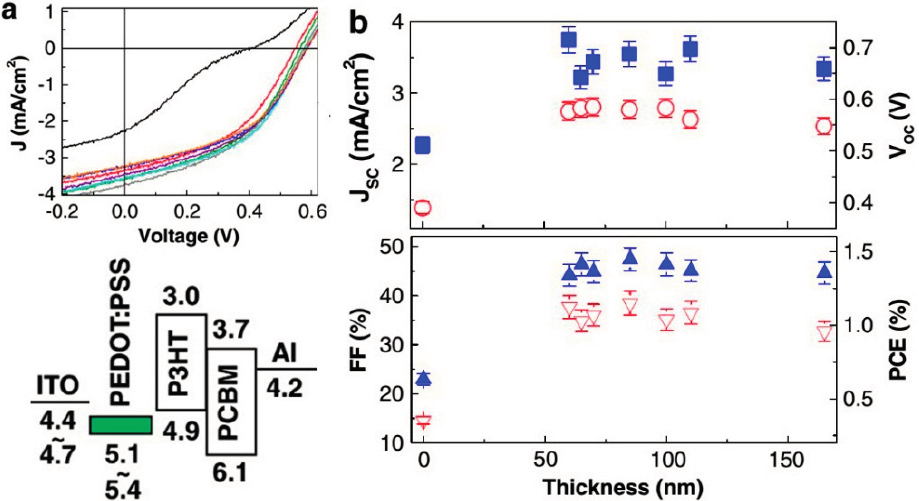
Figure 3. ( a ) (up) J – V characteristics (AM 1.5, 85 mW/cm 2 ) of polymer solar cells with non-annealed P3HT:PCBM layer (70 nm) and non-annealed PEDOT:PSS layer of which thickness is 0 (ITO only; black line), 60 (gray line), 65 (orange line), 70 (purple line), 85 (sky blue line), 100 (blue line), 110 (green line), and 165 nm (red line). (Down) Ideal flat energy band diagram for the device with the PEDOT:PSS IFL layer; ( b ) J sc (filled squares), V oc (open circles), FF (filled upward triangles), and PCE (open downward triangles) as a function of PEDOT:PSS IFL thickness. Reprinted with permission from